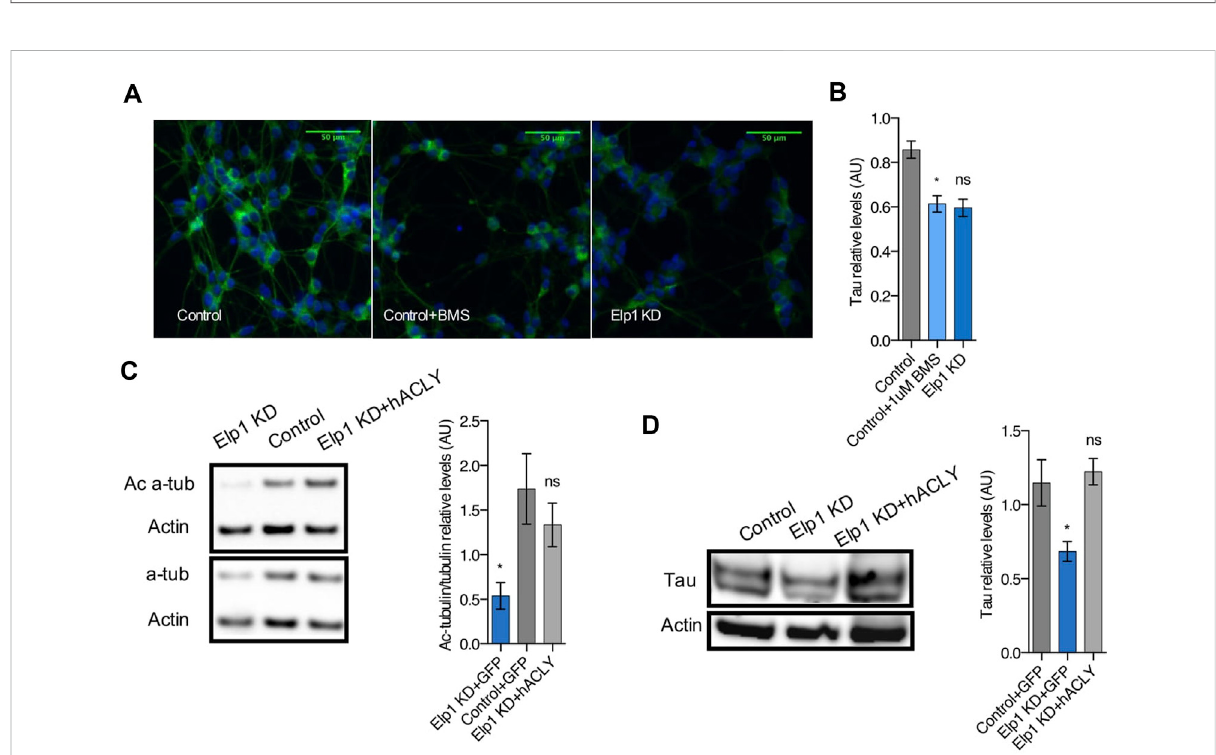
FIGURE 8 Inhibition of Acly interferes with Tau stability and Ac- α -tubulin levels establishing hierarchy involved in neurite morphology defects in Elp1 KD cells . (A – B) Immunolabeling and quanti fi cation of Tau levels in differentiated SHSY5Y extracts from Elp1KD cells and Control cells incubated with vehicleorBMS303141(BMS,1 µM)for72h.Scalebaris50 µm. (C – D) Immunoblotting andquanti fi cationofAcetylated α -tubulin(Ac α -Tub),Total α - tubulin (t α -Tub) (C) and Tau (D) from differentiated SHSY5Y extracts from Control and Elp1 KD cells transfected with ACLY or GFP carrying constructs. All graphs show values of means ± SEM. Signi fi cance was determined by: (B – D) two-sided one-way analysis of variance (ANOVA), Speci fi cally,[ (B) p =0.0072,F=6.112; (C) p =0.0405,F=4.494; (D) p =0.0277,F=5.487;]Inaddition,theposthocmultiplecomparisons,toanalyze statistical difference of each condition compared to control for (B – D) by Dunnett test * p < 0.05. n = Number of wells (each well contains data from 20 fi elds, each fi eld contains hundreds of cells): (B) Control n = 4; Control + BMS n = 7; Elp1KD n = 16; n = Number of experimental repeats: